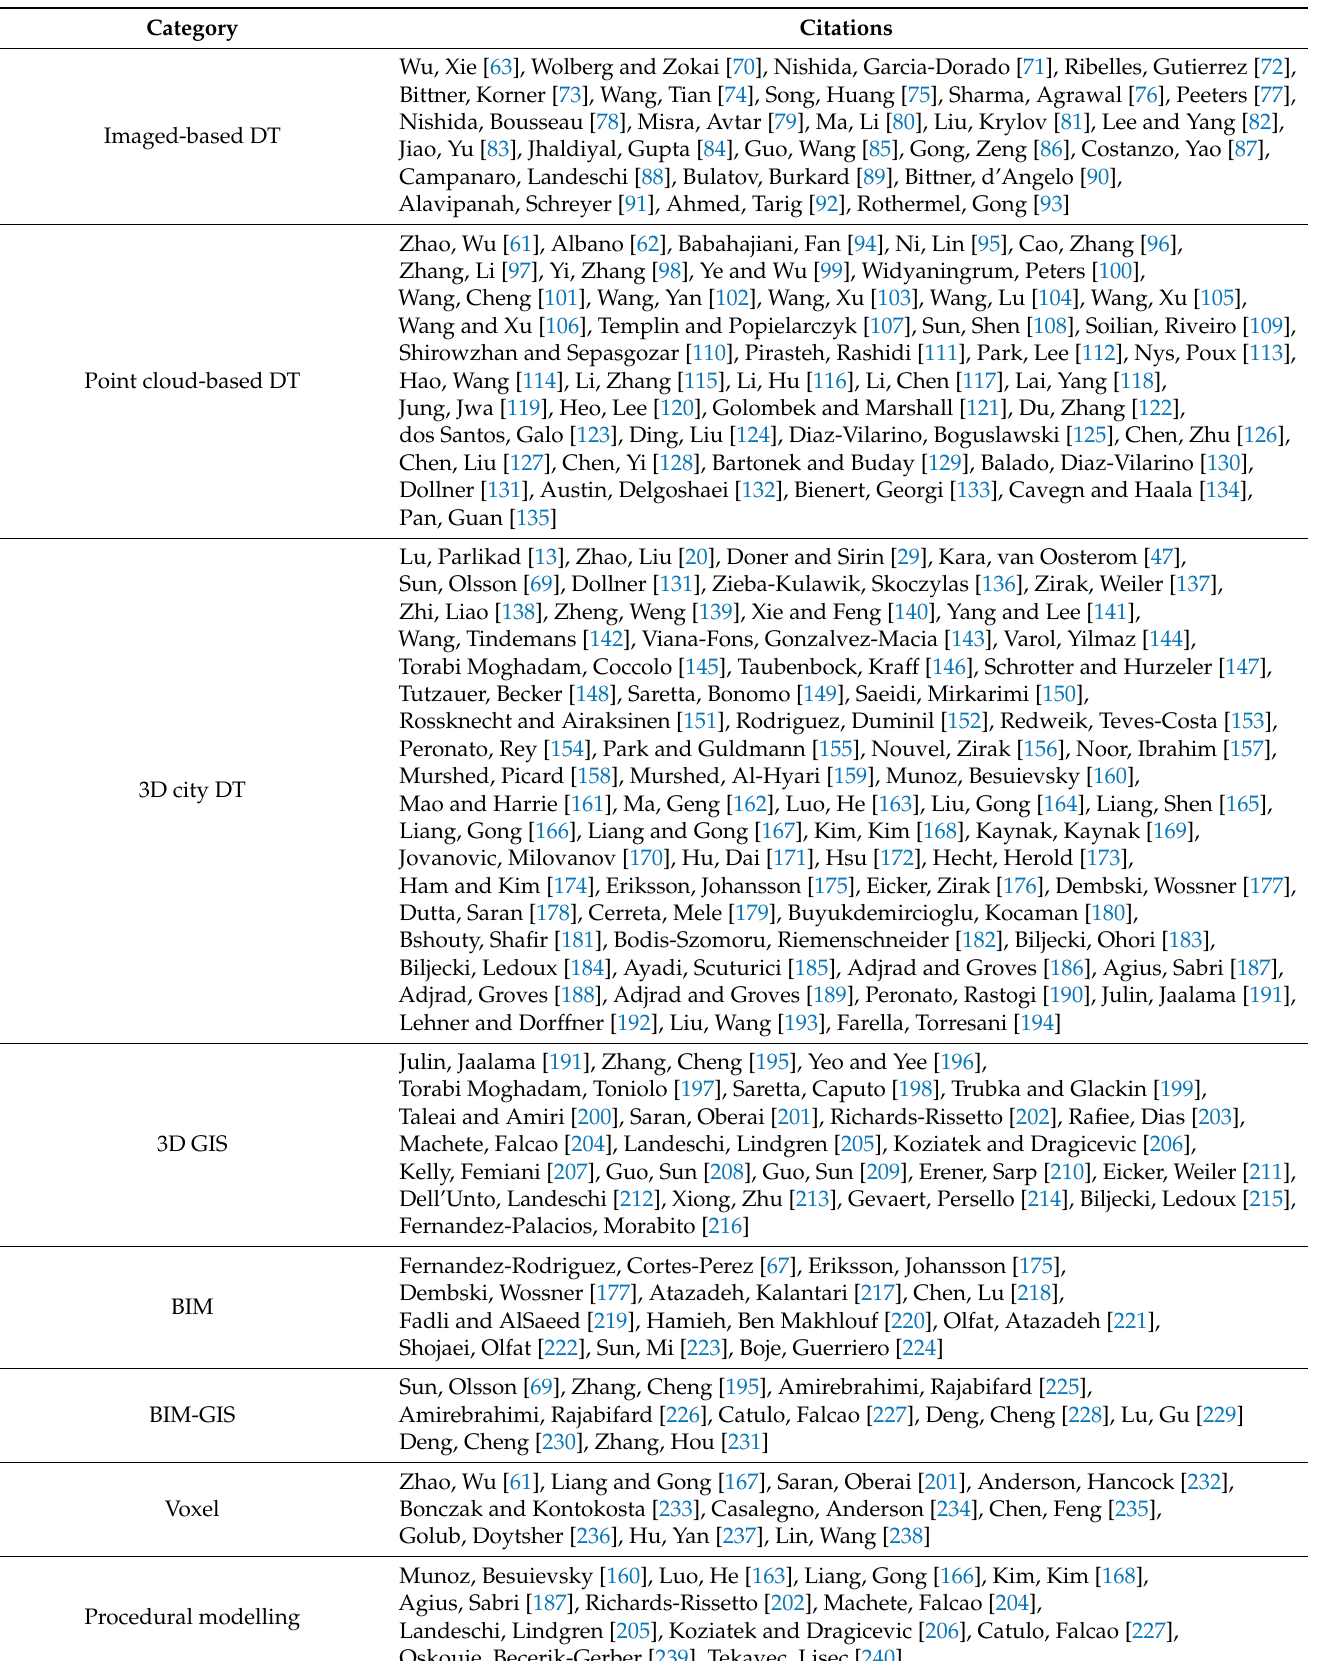
Table 4. Full list of (n = 180) publications categorized by initially used input